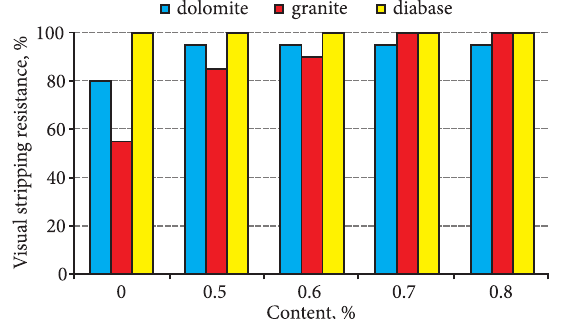
Fig. 3. Stripping resistance with bitumen BDUS 70/100 from Russia containing polyphosphoric acid based liquid